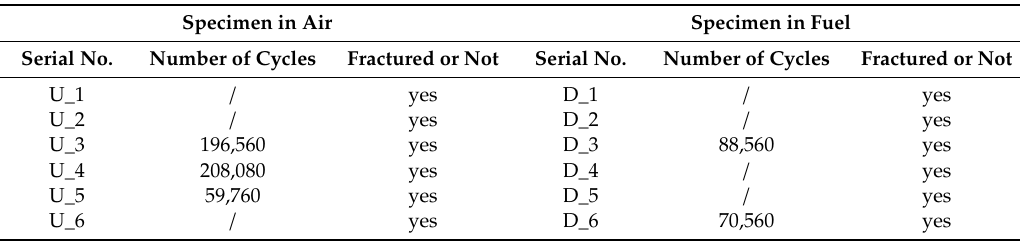
Table 7. Test results at an acceleration of 13.45 g.